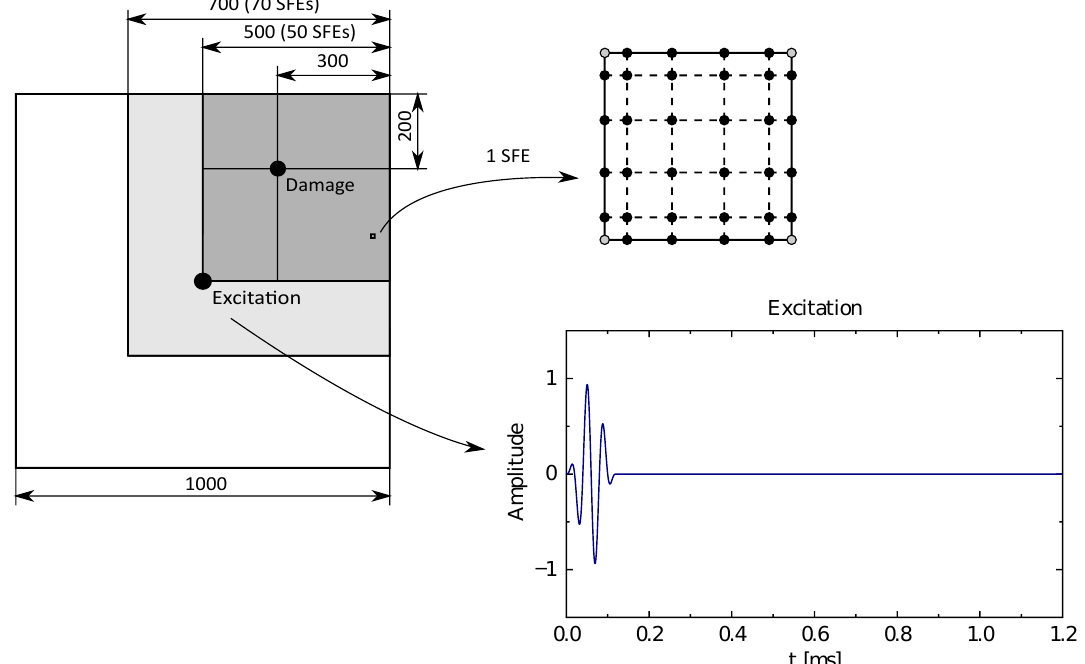
Figure 1. Examined composite panel with 1 SFE, nodes distribution and excitation